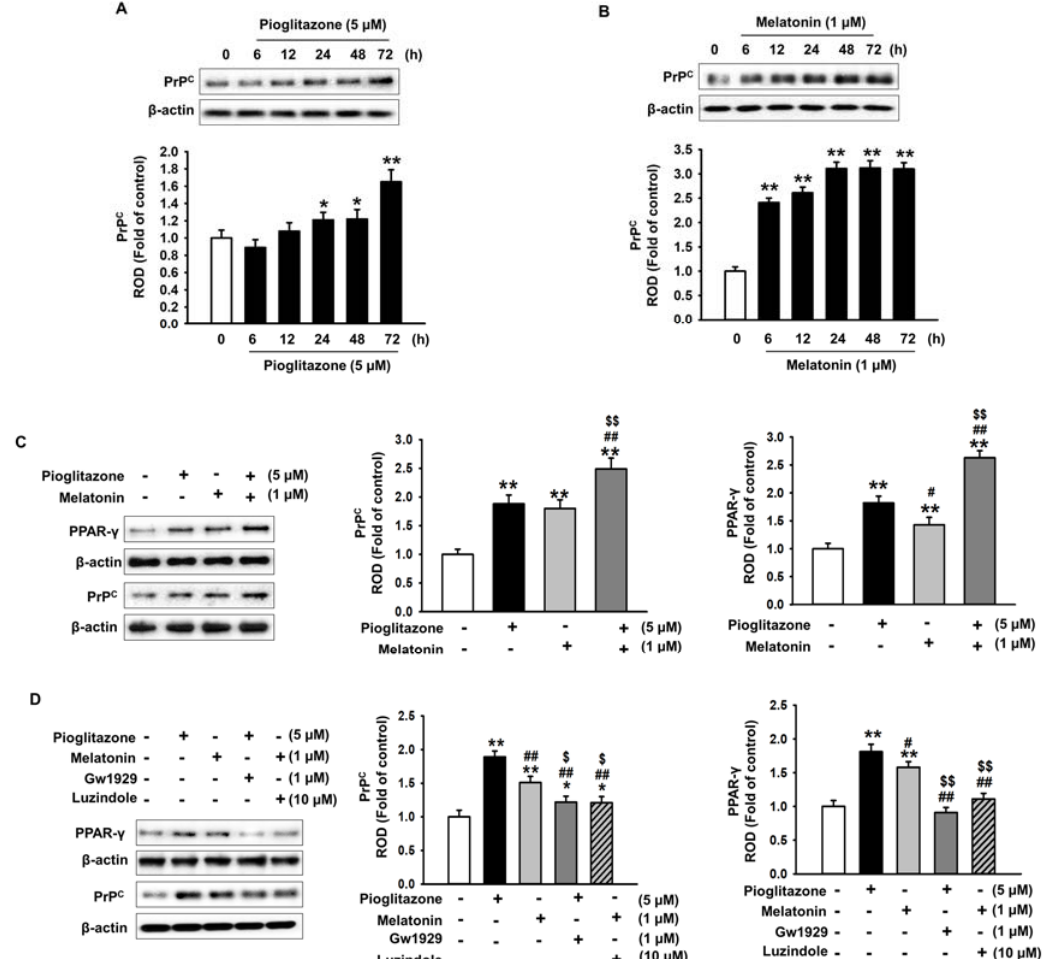
Figure 4. Pioglitazone and melatonin regulate cellular prion protein expression. ( A ) Western blotting of cellular prion protein (PrP C ) in MSCs pretreated with pioglitazone (5 µ M) for 0, 6, 12, 24, 48, and 72 h ( n = 3). The values represent the mean ± SEM; * p < 0.05 and ** p < 0.01 vs. control (ANOVA, using Dunnett’s post ‐ hoc test); ( B ) western blotting analysis of PrP C in MSCs pretreated with melatonin (1 μ M) for 0, 6, 12, 24, 48, and 72 h ( n = 3). The values represent the mean ± SEM; ** p < 0.01 vs. control